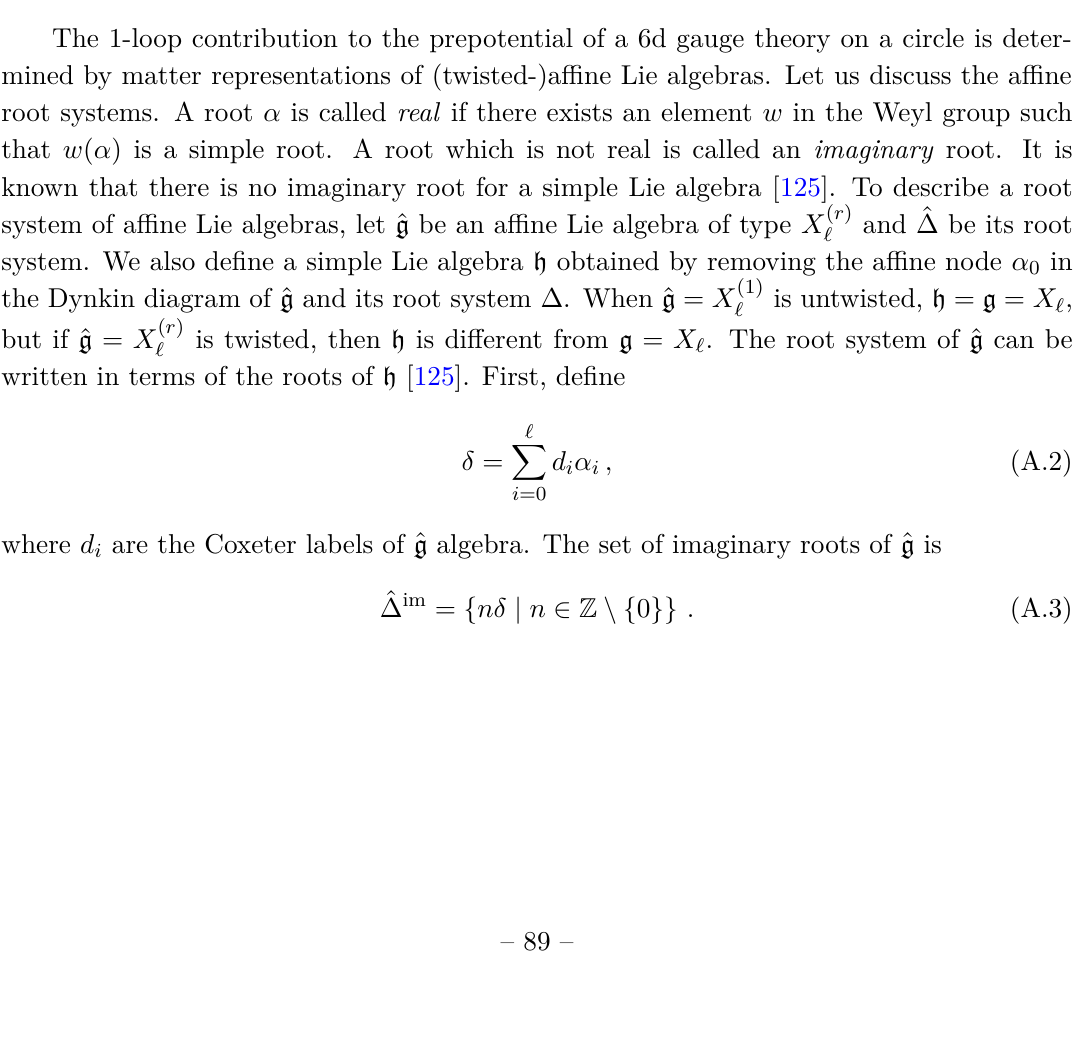
Figure 8. Dynkin diagrams of twisted affine Lie algebras X ( r =2 , 3) node is the dual Coxeter label (comark) d ∨ represented as a red